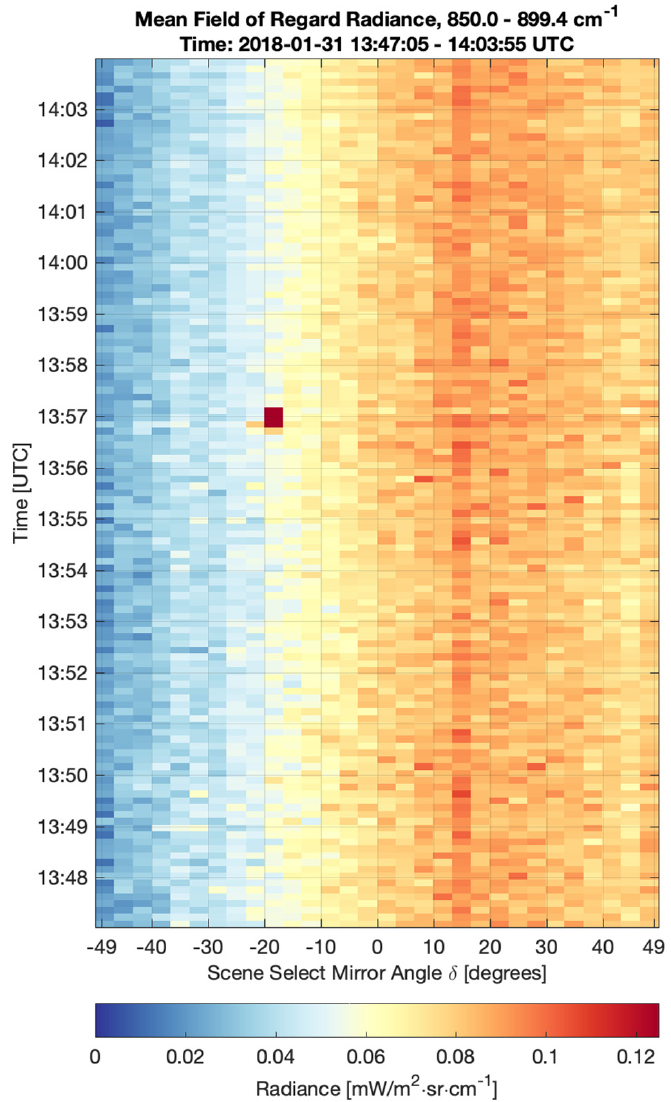
Figure 11. NOAA-20 CrIS radiance image, spectrally averaged from 850–900 cm − 1 , and averaged over all fields of view during the pitch maneuver, plotted versus time (y-axis) and scene select mirror angle (x-axis). An outlier in the calibrated radiance is evident at approximately 13:57 UTC for FOR 21 (at approximately − 20 ◦ SSM angle). This effect is also obvious in the imaginary part of the calibrated radiance, and a spike in roll and yaw data is also observed at this time (Figure 7). One of the most important aspects of the analyses is inspection and quality control of the data such that outliers such as this do not impact the analysis.